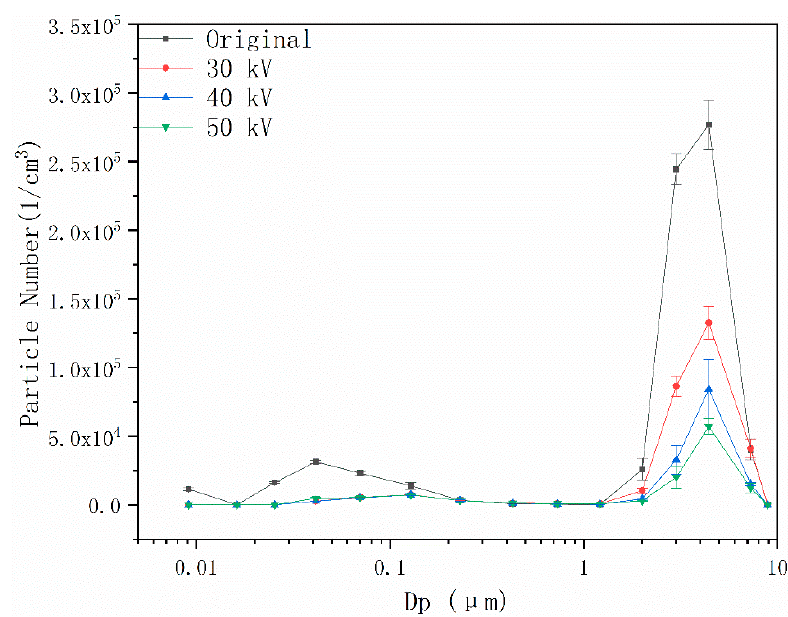
Figure 14. Number concentration of 4- μ m particles at different voltages.